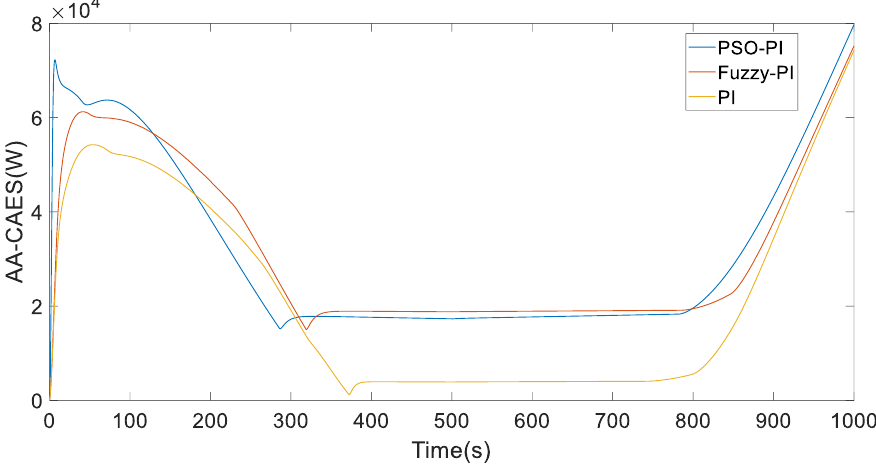
Figure 32. Output power of AA-CAES in Example 3.